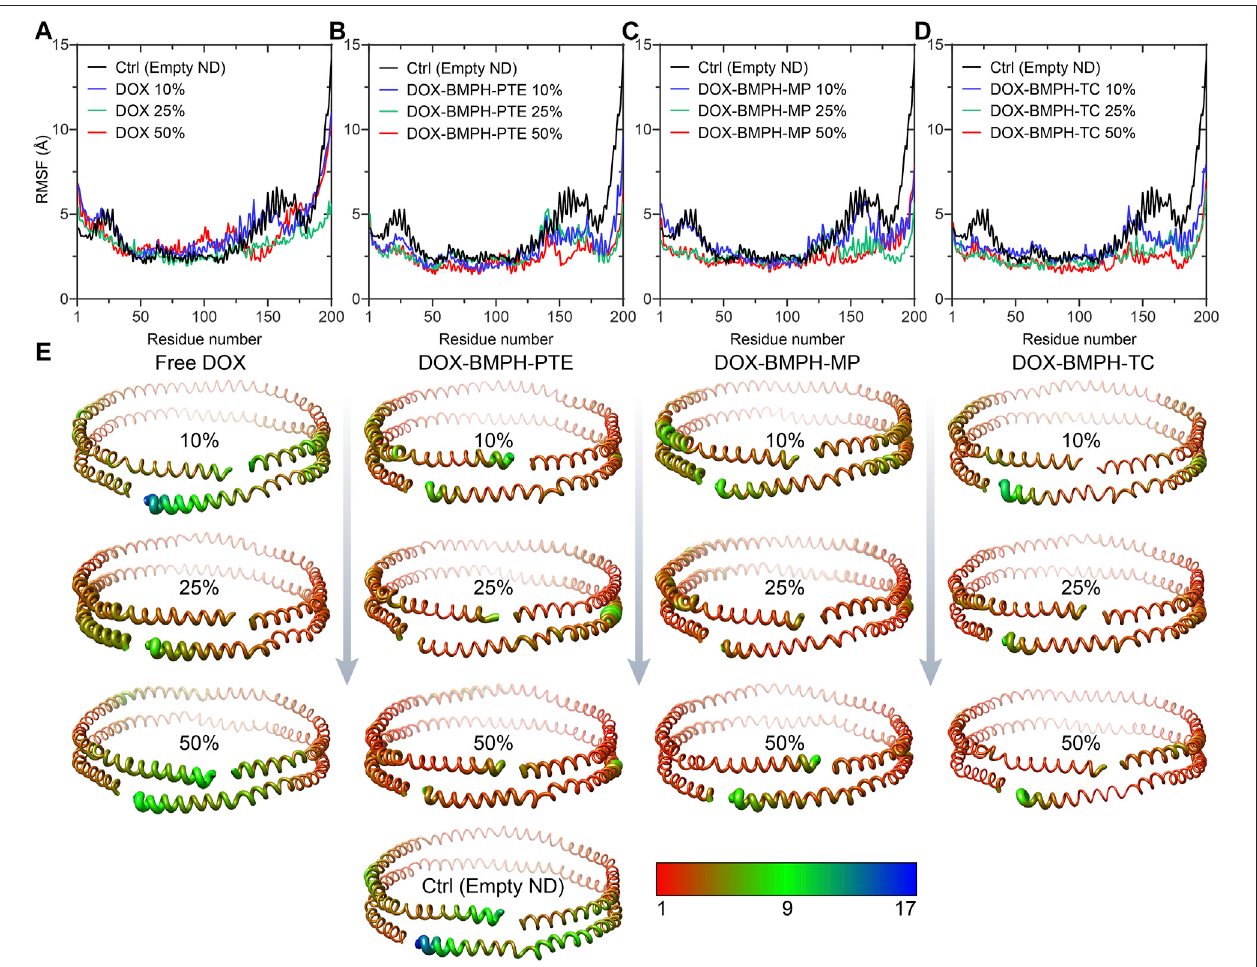
FIGURE 7 | Root Mean Square Fluctuation (RMSF) analyses MSP1 protein assembled with different DOX-ND formulations. Each MSP1 contained 200 residues, and the abscissa in the line charts represents the average value of RMSF in the same residue of two MSP1 proteins. RMSF of four systems compared with MSP1 residues in the empty ND: (A ) MSP1 residues in the free DOX-ND formulations. (B) MSP1 residues in DOX-BMPH-PTE ND formulations. (C) MSP1 residues in DOX- BMPH-MP ND formulations. (D) MSP1 residues in DOX-BMPH-TC ND formulations. (E) Comparison of the fl uctuations of each residue between four ND formulations and the empty ND with variants colored and sized according to its RMSF contribution. The coloring-thickness scale varies from deep red and thin (low fl uctuations) to dark blue and thick (high fl uctuations).